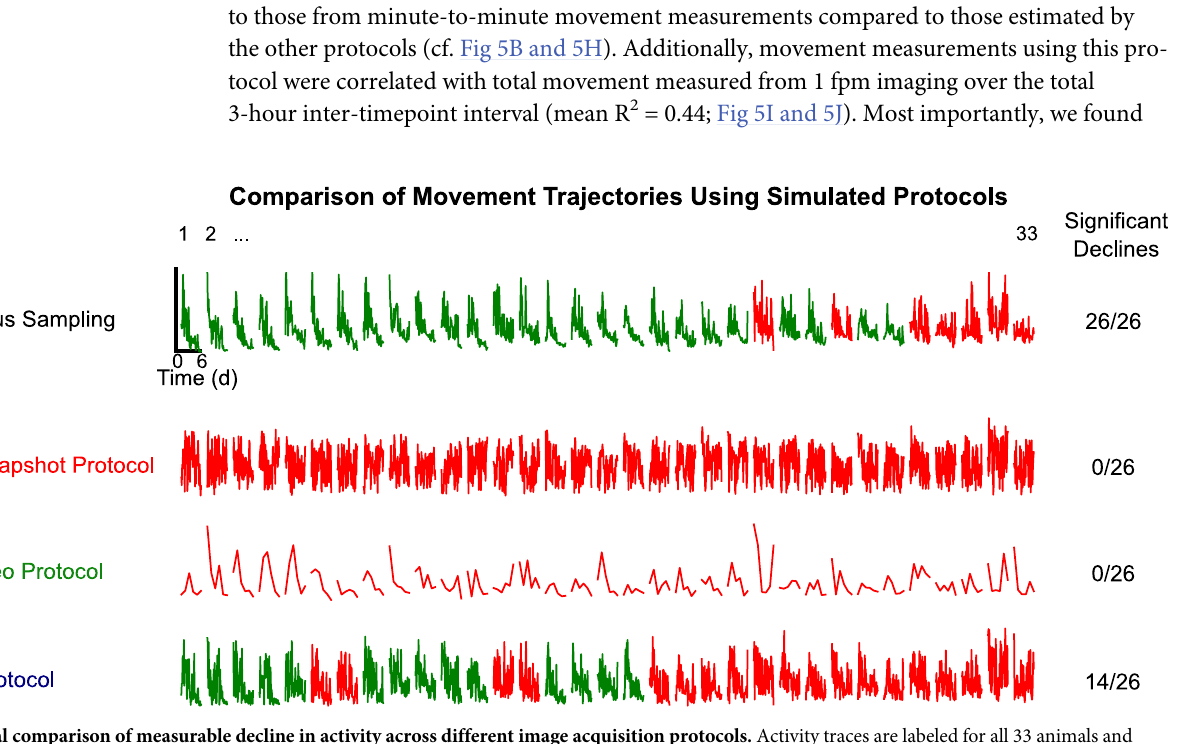
PLOS ONE | https://doi.org/10.1371/journal.pone.0257591 February 2,